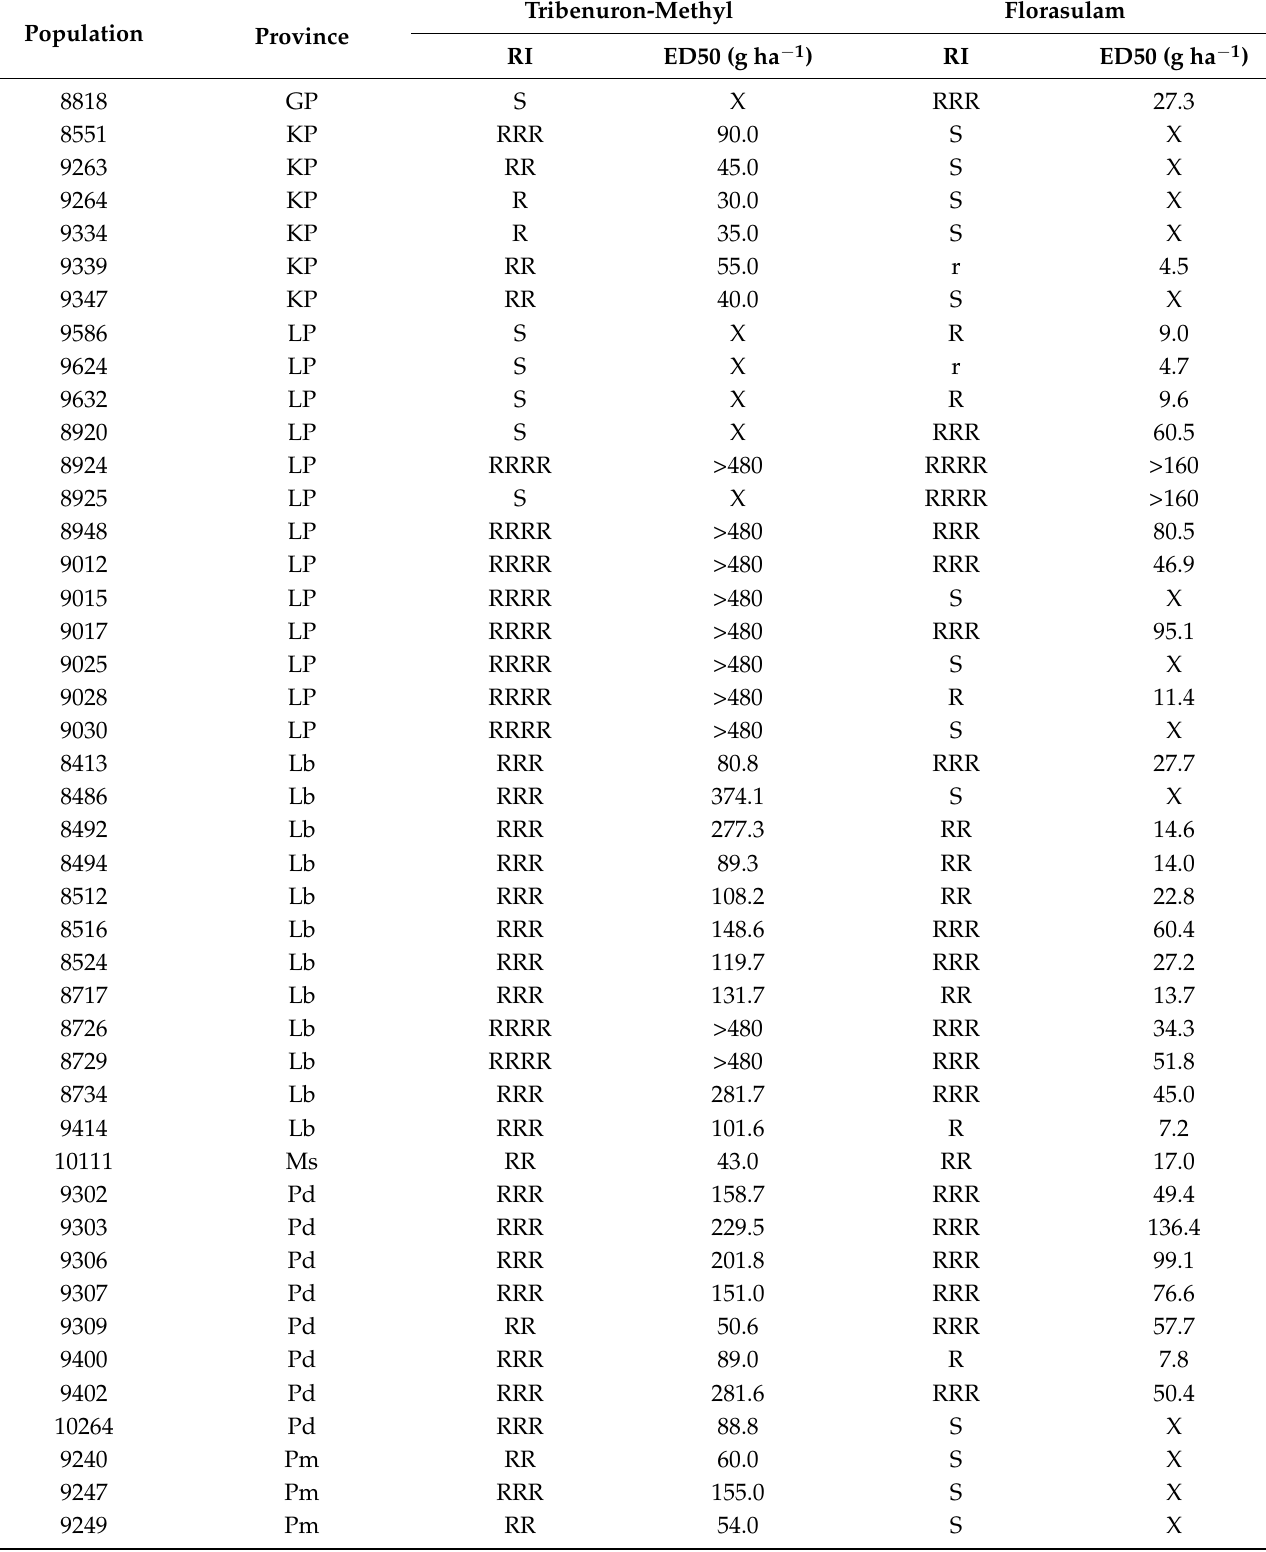
Table 3. Populations of cornflower resistant to acetolactate synthase inhibitors characterised by ED50 (effective dose causing 50% shoot fresh weight reduction in the treated plants) and resistance index